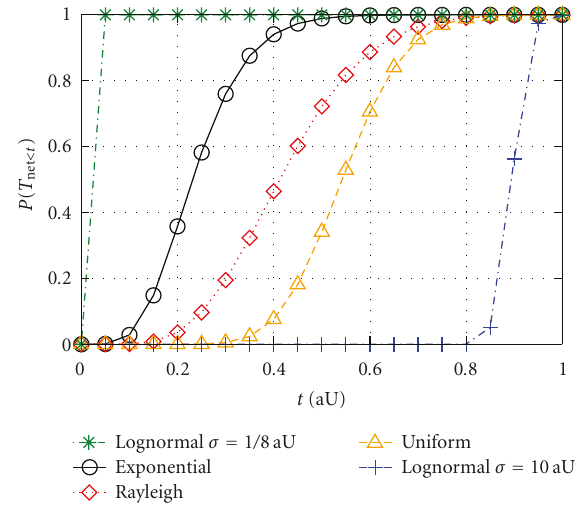
Figure 4: CDF of the network lifetime, as a function of time, in a scenario with N = 32 sensors, uniform clustering, ideal reclustering , and SNR sensor = 5dB. The QoS condition is set to P ∗ distributions for the sensor lifetime in (10) are considered. Lines are associated with analysis, whereas symbols are associated with